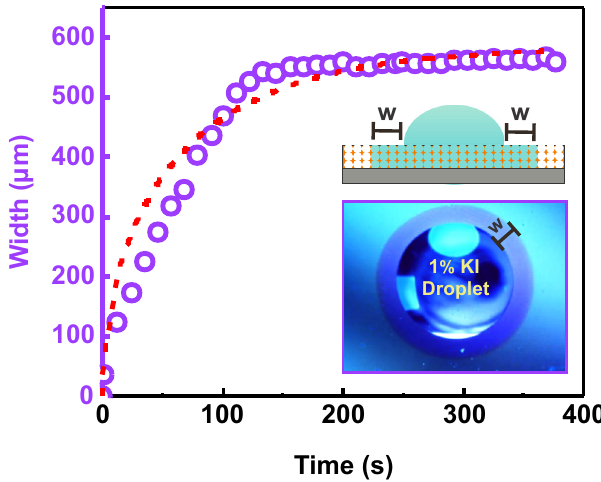
Fig. 2 Typical nano fl uidic in fi ltration feature when a droplet is placed on a nanoporous thin fi lm. Width (w) of the self-in fi ltrated annulus region (see sketch illustration) around a 1 wt% KI aqueous droplet deposited on the nanoporous titania thin fi lm as a function of time (T = 25 °C and 45% RH). Symbols represent the experimental data and the red dotted line is the prediction from the kinematic in fi ltration − evaporation equation with c I ¼ 1800 μ m 2 s (cid:2) 1 and τ ¼ 175s. (see text for details). Note the capillary in fi ltration arrested at a given annulus width, resulting from the competition between the in fi ltration and the evaporation processes. The inset shows an optical picture of the annulus in the periphery of the sessile KI